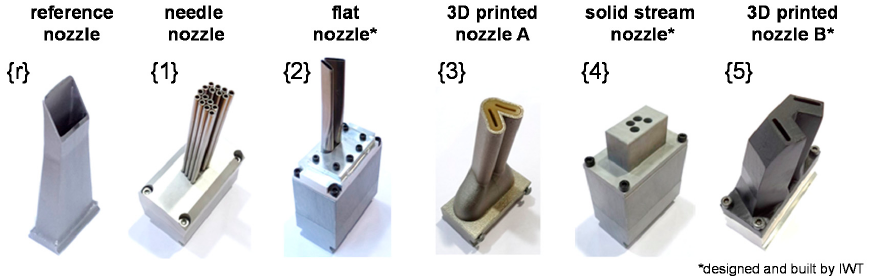
Figure 2. Different concepts of fluid supply nozzles.